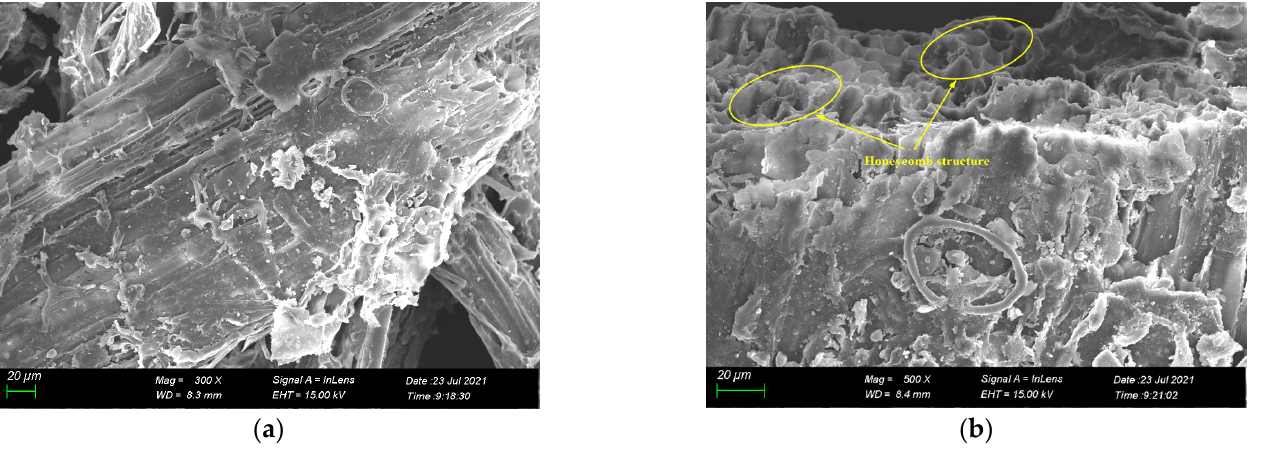
Figure 4. SEM image of YDA at ( a ) ×300 and ( b ) ×500 magnifications.